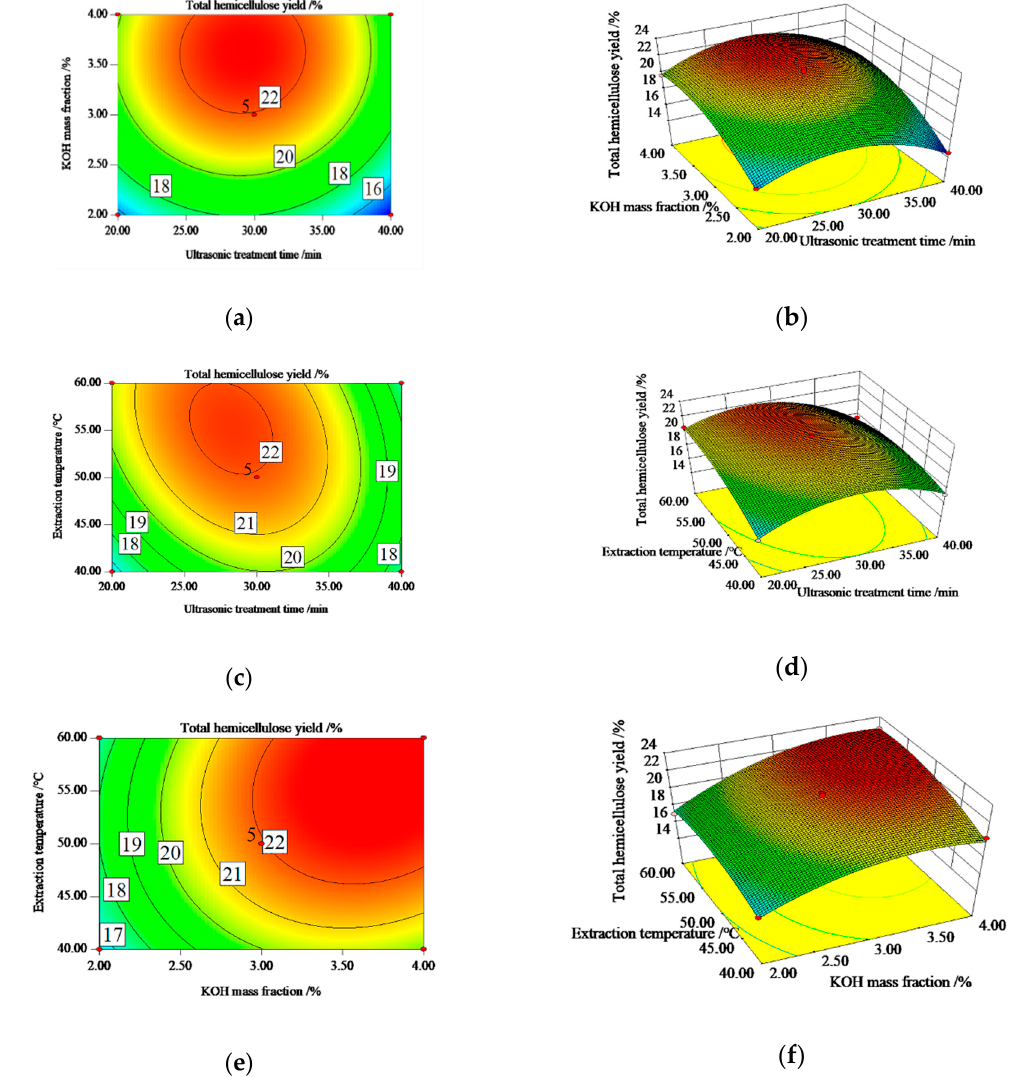
Figure 2. Response surface and contour plots showing effects extraction temperature, ultrasonic treatment time and KOH mass fraction on total hemicellulose of BP. ( a ) and ( b ) ultrasonic treatment time vs. KOH mass fraction (extraction temperature = 50 °C). ( c ) and ( d ) extraction temperature vs. ultrasonic treatment time (KOH mass fraction = 3%). ( e ) and ( f ) KOH mass fraction vs. ultrasonic treatment time (temperature = 30 min).